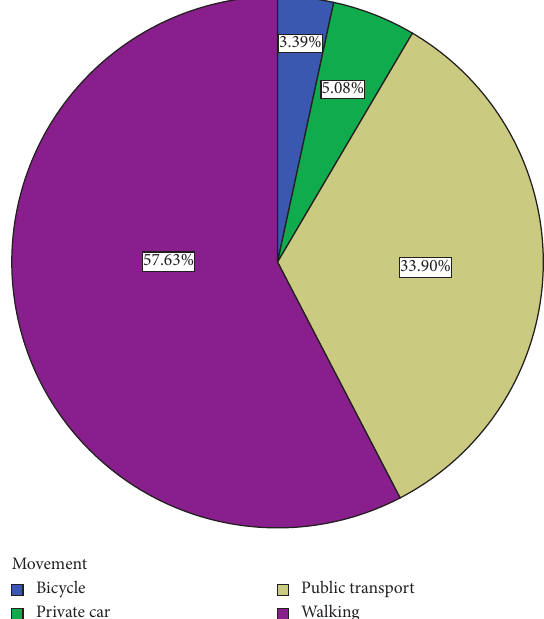
Figure 6: Distribution of means of transportation of participants to their workplaces.